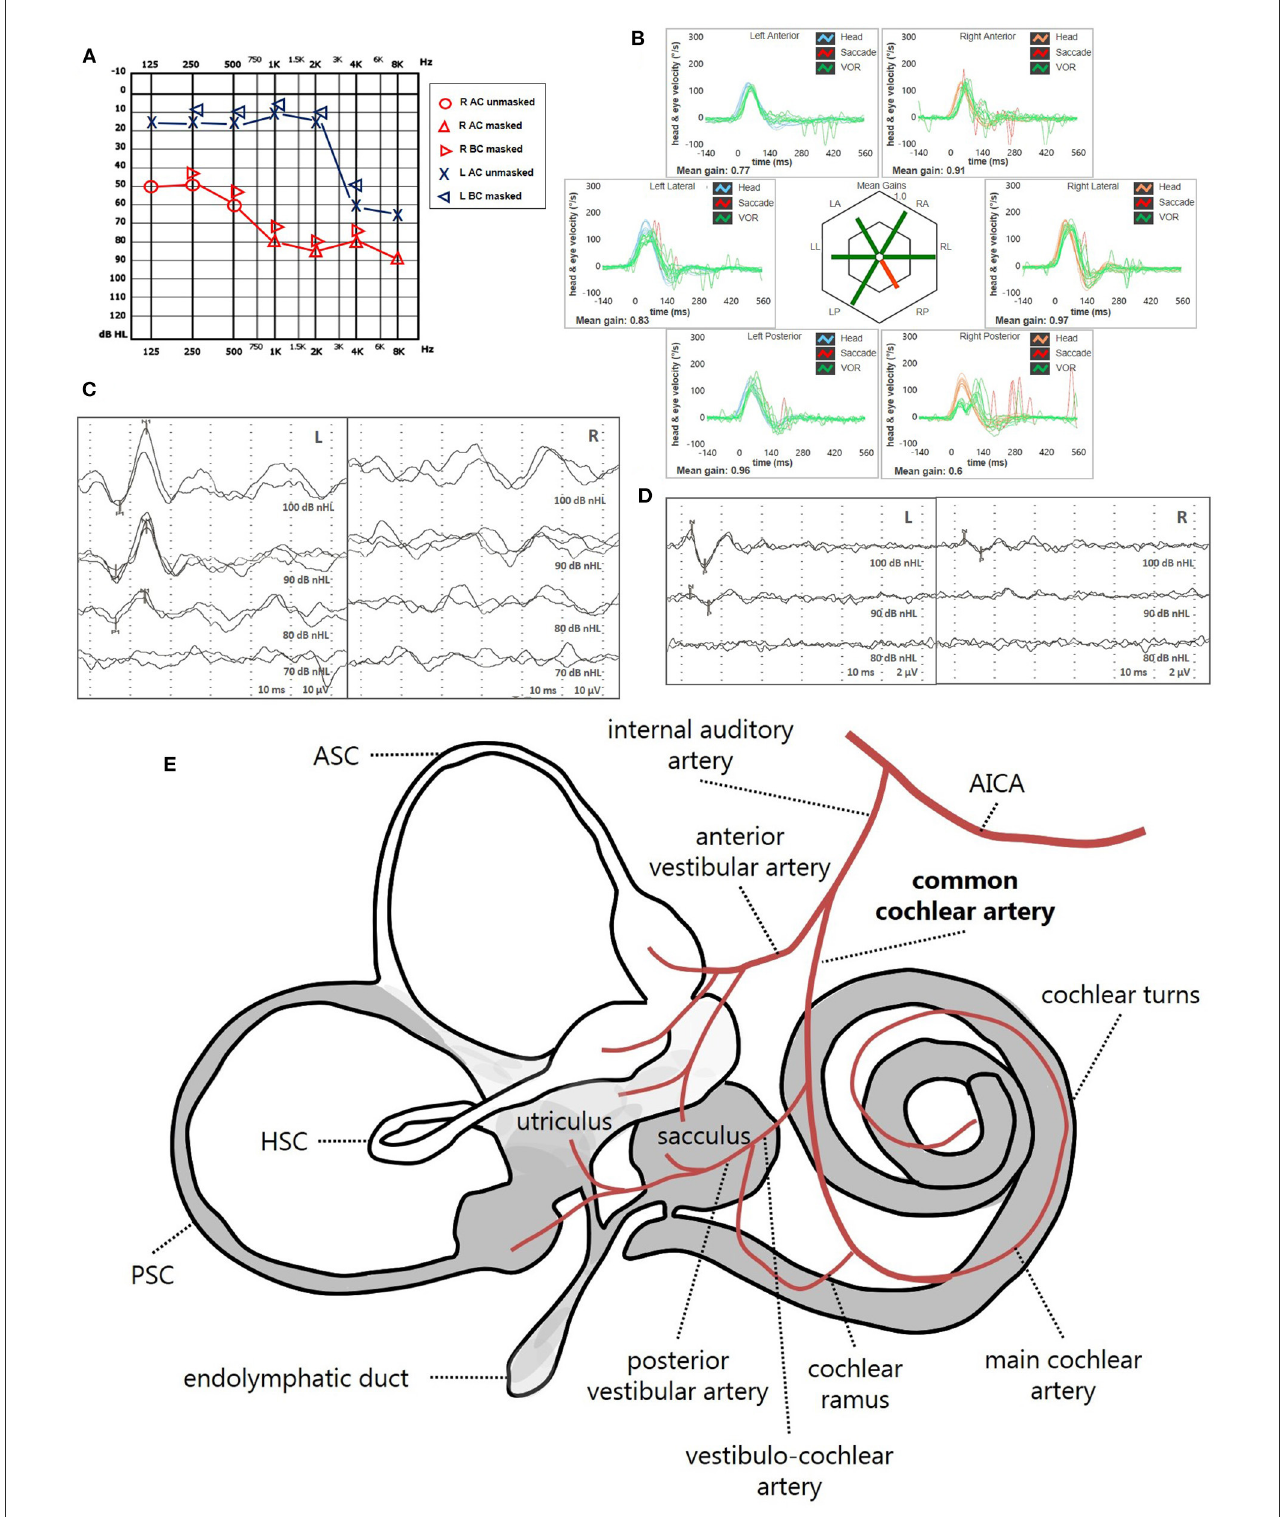
FIGURE12 Presenting scenario of patients #64 with an instrumental lesion pattern consistent with an ischemic damage in the territory mainly supplied by the right CAA (see also the Supplementary Video 2). (A) Pure-tone audiometry exhibiting severe down-sloping sensorineural HL on the right side. (B) vHIT showing a selective VOR-gain impairment for the right PSC (0.6) with both overt and covert saccades. (C) cVEMPs revealing absent potentials on the right side and normal responses on the left side (AR = 100%). (D) oVEMPs with potentials on both sides with an abnormal amplitude asymmetry (L > R, AR = 33%). (E) Labyrinthine receptors mainly supplied by the CCA are represented in gray. AC, air-conduction; AICA, anterior-inferior cerebellar artery; ASC, anterior semicircular canal; BC, bone-conduction; CCA, common-cochlear artery; cVEMPs, cervical vestibular-evoked myogenic potentials; HSC, horizontal semicircular canal; L, left; LA, left anterior; LL, left lateral; LP, left posterior; oVEMPs, ocular vestibular-evoked myogenic potentials; PSC, posterior semicircular canal; R, right; RA, right anterior; RL, right lateral; RP, right posterior; vHIT, video-head impulse test; VOR, vestibulo-ocular